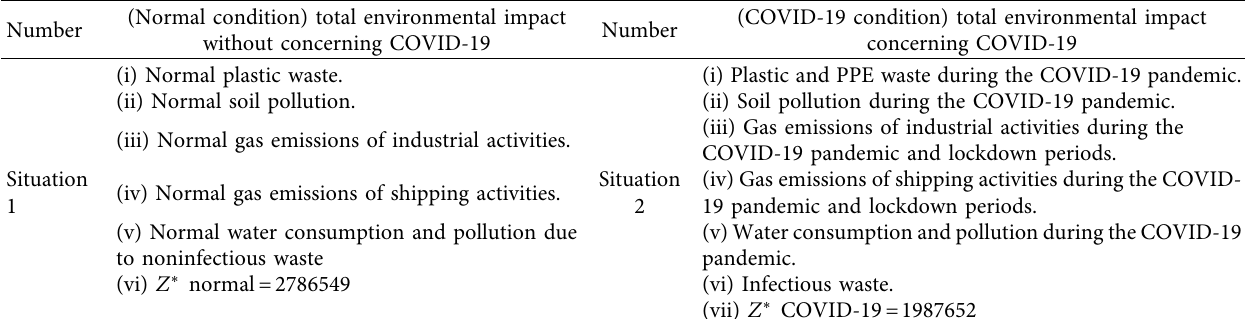
Table 5: The optimization value of the environmental OF with different